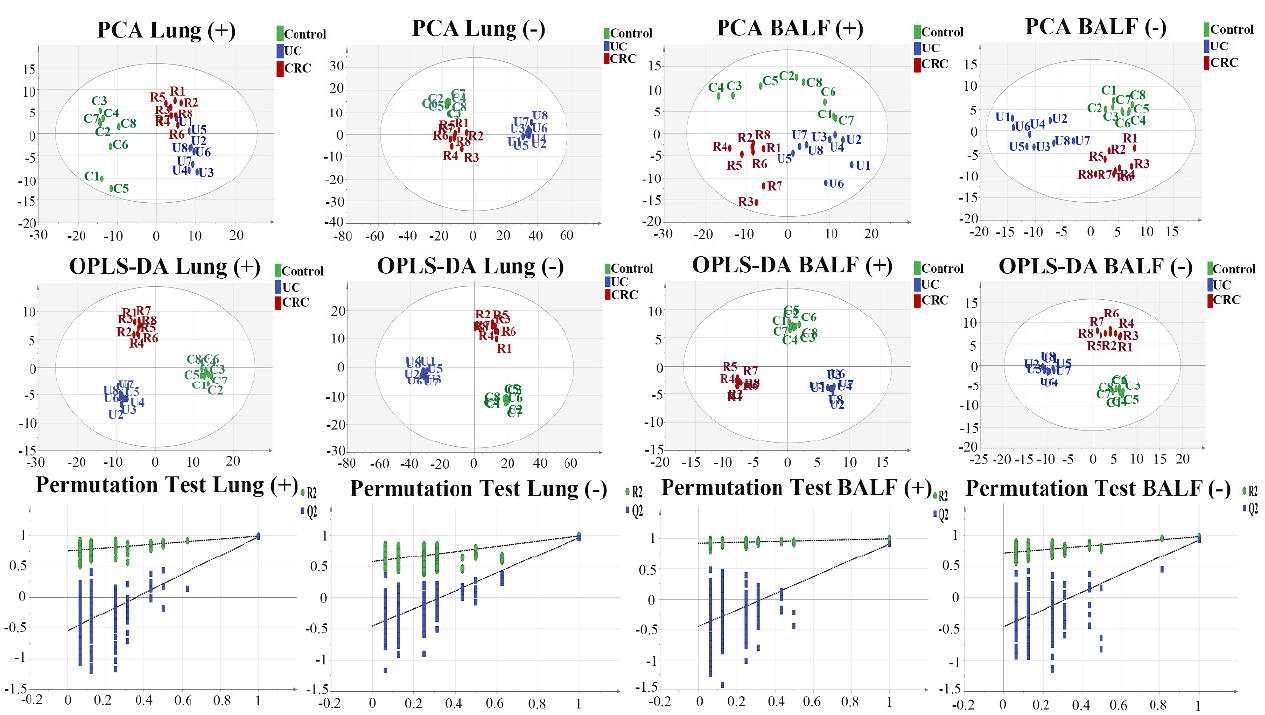
Figure 1. The PCA score plots of the control, UC, and CRC groups for the BALF in ESI (+), R2 = 0.562; BALF in ESI ( − ), R2 = 0.572; for the lung tissue in ESI (+), R2 = 0.577; lung tissue in ESI ( − ), R2 = 0.732. Green, blue, and red dots are used to label the control, UC, and CRC groups, respectively. OPLS-DA score plots of the control, UC, and CRC groups for the BALF in ESI (+), R2 = 0.995, Q2 = 0.879; BALF in ESI ( − ), R2 = 0.982, Q2 = 0.909; lung tissue in ESI (+), R2 = 0.987, Q2 = 0.915; lung tissue in ESI ( − ), R2 = 0.993, Q2 = 0.965. Green, blue, and red dots are used to label the control, UC, and CRC groups, respectively. Validation plots of the OPLS-DA models obtained using the 200 permutation tests for the BALF in ESI (+), R2 = 0.922, Q2 = − 0.457; BALF in ESI ( − ), R2 = 0.715, Q2 = − 0.504; lung tissue in ESI (+), R2 = 0.761, Q2 = − 0.480; lung tissue in ESI ( − ), R2 = 0.574, Q2 = − 0.405. Green and blue dots stand for the R2 and Q2,